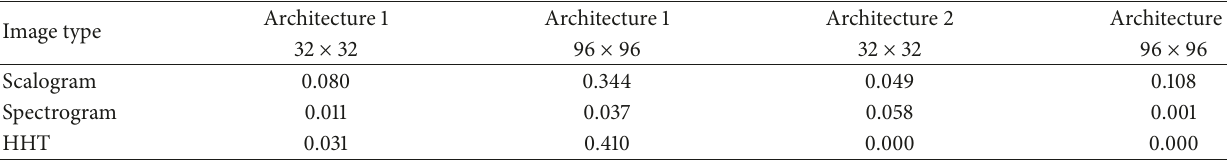
Table 8: MFPT paired two-tailed 𝑡 -test 𝑝 values.